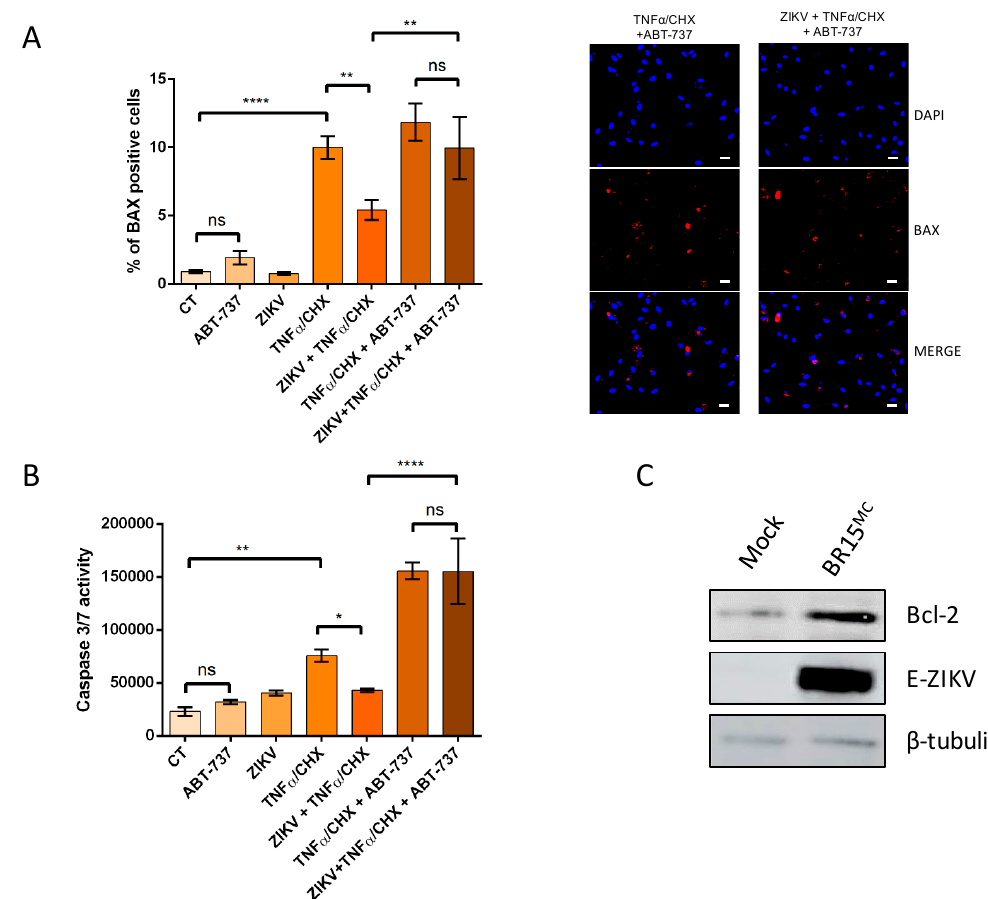
Figure 8. Inhibition of anti-apoptotic Bcl-2 family proteins abrogates the protection mediated by ZIKV. A549 cells were infected with ZIKV at MOI of 1. TNF α and CHX were added 2 h post infection for 6 h with or without ABT-737. A549 cells were immunostained with an anti-BAX antibody (representative images in panels on the right, white scale bar: 10 µ m) ( A ) and caspase 3 / 7 activity was followed after treatment ( B ). A549 cells were infected with ZIKV at MOI of 1 and level of Bcl-2 was followed by western blot 24 h post infection ( C ). Values represent the mean and standard deviation of three independent experiments. Data were analyzed by a one-way ANOVA test with post-hoc Tukey’s test (* p < 0.05; ** p < 0.01; *** p < 0.001, **** p < 0.0001, ns = not significant).